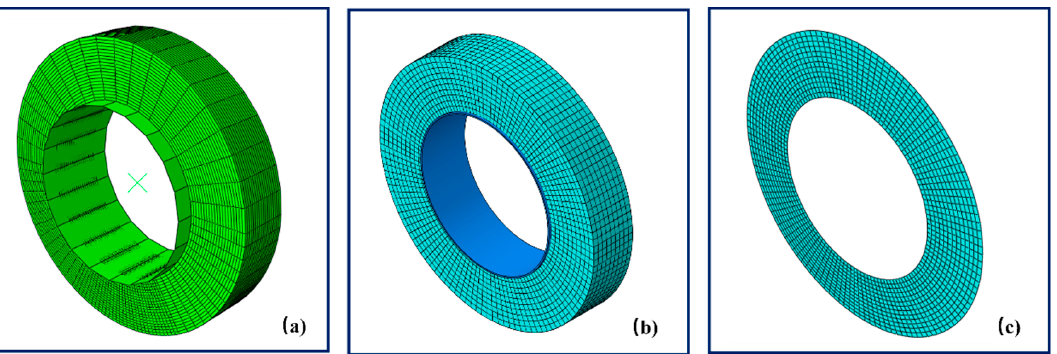
Figure 4. ( a ) The Lagrangian–Eulerian solid tire model, ( b ) the Lagrangian solid tire model, and ( c ) the Plane Strain solid tire model.